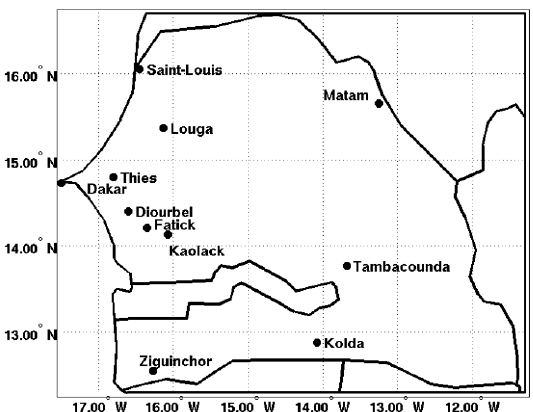
Figure 1. Meteorological and malaria observation stations. The map shows the locations of the stations used in this study. The stations in alphabetical order are: Dakar (14.73 ◦ N, 17.5 ◦ W), Diourbel (14.4 ◦ N, (15.37 ◦ N, 16.13 ◦ W), Matam (15.65 ◦ N, 13.25 ◦ W), Saint-Louis (16.05 ◦ N, 16.45 ◦ W),